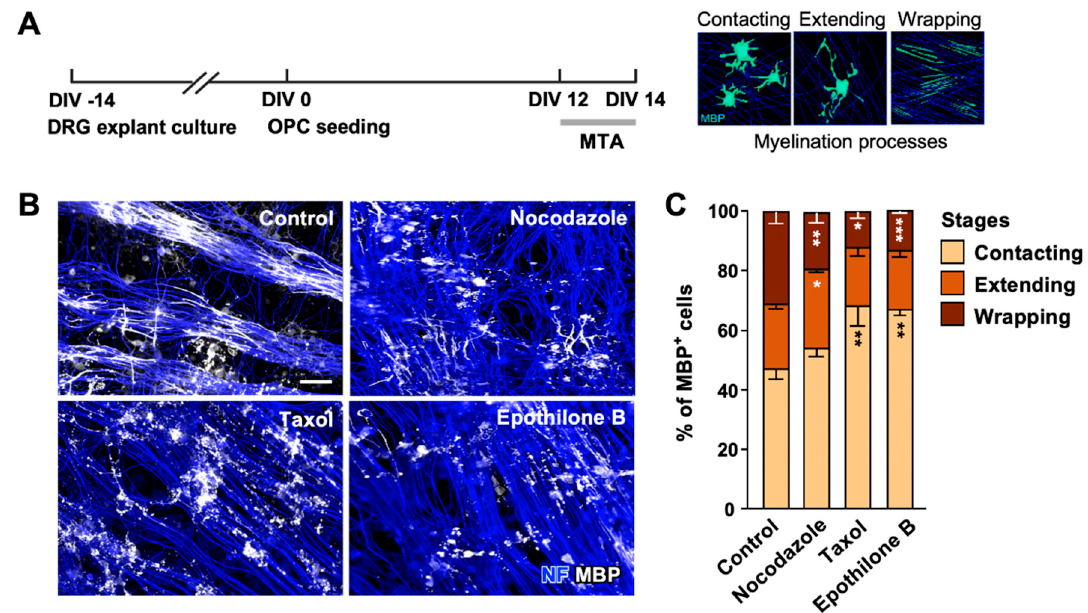
Figure 5. MT dynamics is essential for myelination. ( A ) Experimental timeline of myelinating co-cultures of OPCs and dorsal root ganglion (DRG) explants ( left ). Illustrations of myelinating oligodendrocytes are shown on right . DRGs were cultured and maintained for 14 days, and purified OPCs were added to the DRG explant culture at DIV 0. Co-cultures were treated with MTAs (2 nM) at DIV 12 and fixed at DIV 14. Myelination proceeds through three stages, contacting, extending, and wrapping. ( B ) Representative images of co-cultures stained with anti-neurofilament (NF) and anti-MBP antibodies. Scale bar, 25 µ m. ( C ) Quantification of myelination. Myelinating oligodendrocytes were categorized as depicted in A. Graph shows mean ± SEM. n = 4. * p < 0.05, ** p < 0.01, and *** p < 0.001, Mann–Whitney test.